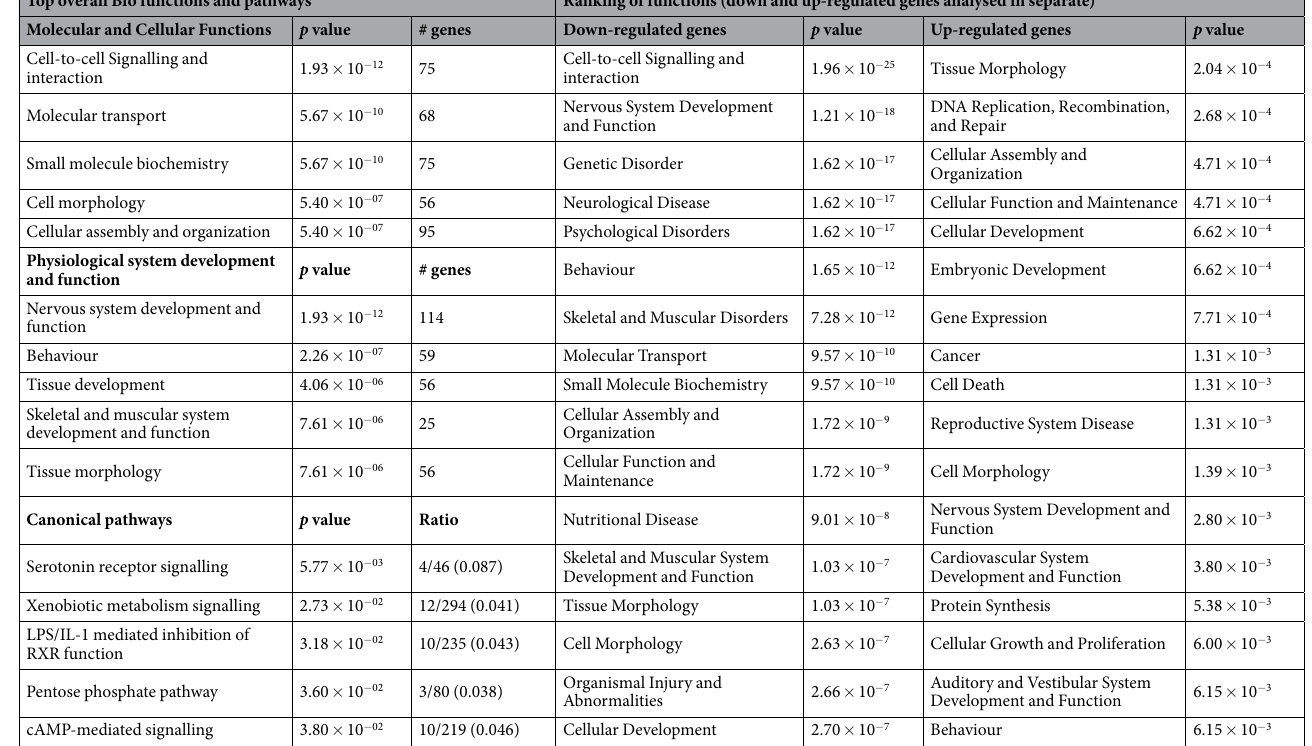
Table 1. Ingenuity pathway analysis of HF/DDE regulated genes, either evaluating the overall differentially transcribed genes or with down and up-regulated genes analysed in separate. The ratio refers to the proportion of molecules within the